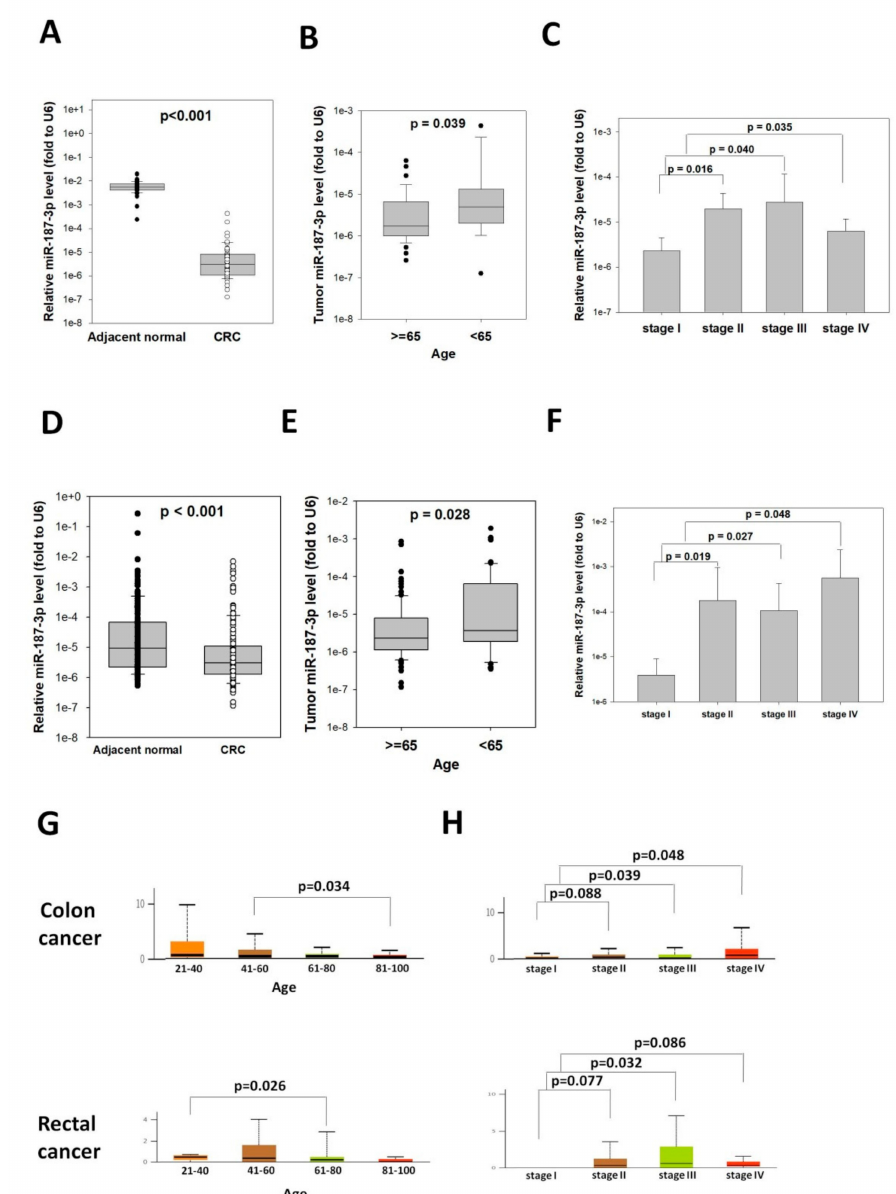
Figure 4. MiR-187-3p levels were associated with the age and tumor stage of CRC patients: ( A ) MiR- 187-3p levels in paired CRC and adjacent normal tissues of 56 CRC patients in the study cohort. ( B ) The miR-187-3p levels were significantly lower in patients aged 65 years or above compared to those aged below 65. ( C ) The miR-187-3p levels were significantly higher in stage II–IV CRCs compared to stage I CRCs. ( D ) MiR-187-3p levels in paired CRC and adjacent normal tissues of 160 CRC patients in the validation cohort. ( E ) The miR-187-3p levels were significantly lower in patients aged 65 years or above compared to those aged below 65. ( F ) The miR-187-3p levels were significantly higher in stage II–IV CRCs compared to stage I CRCs. ( G ) TCGA analysis showed that miR-187-3p levels were significantly different between different age groups in patients with colon cancer (upper panel) or rectal cancer (lower panel). ( H ) TCGA analysis showed that miR-187-3p levels were significantly higher or tended to be higher in stage II–IV CRCs compared to stage I CRCs for patients with colon cancer (upper panel) or rectal cancer (lower panel). · and indicated the (cid:35) individual data points of adjacent normal tissues and CRC,